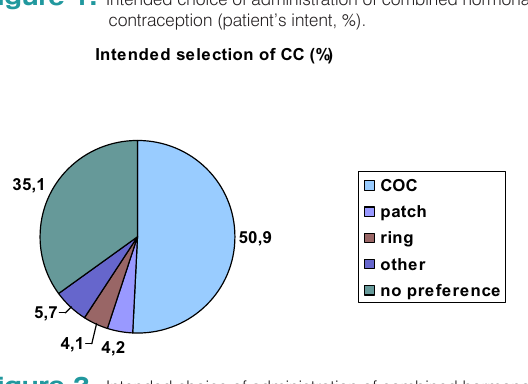
Figure 2. Intended choice of administration of combined hormonal contraception (patient’s intent combined with doctor’s opinion, %).